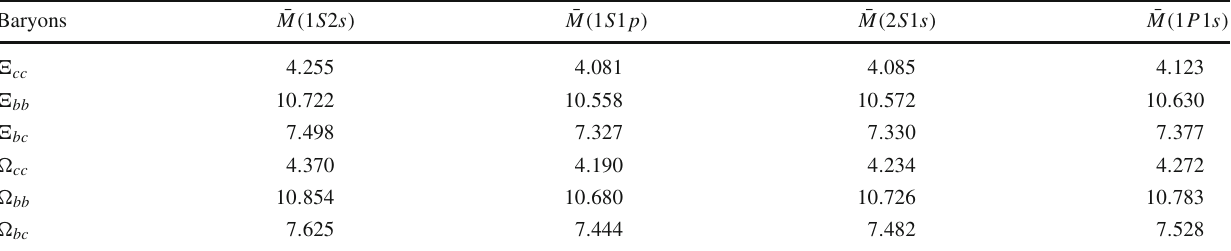
Table 3 Spin-averaged (mean) masses of the excited DH baryons (cid:2) QQ (cid:2) and (cid:3) QQ (cid:2) predicted by Eqs. (17), (27), (28), with the masses in Eqs. (11), (16). All masses in GeV